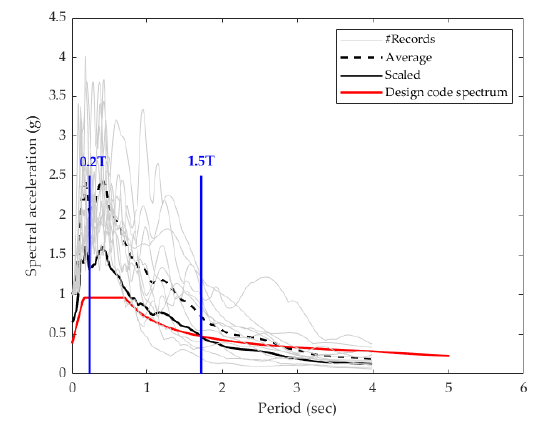
Figure 3. Process of scaling for the 10-story (R-BRBF).